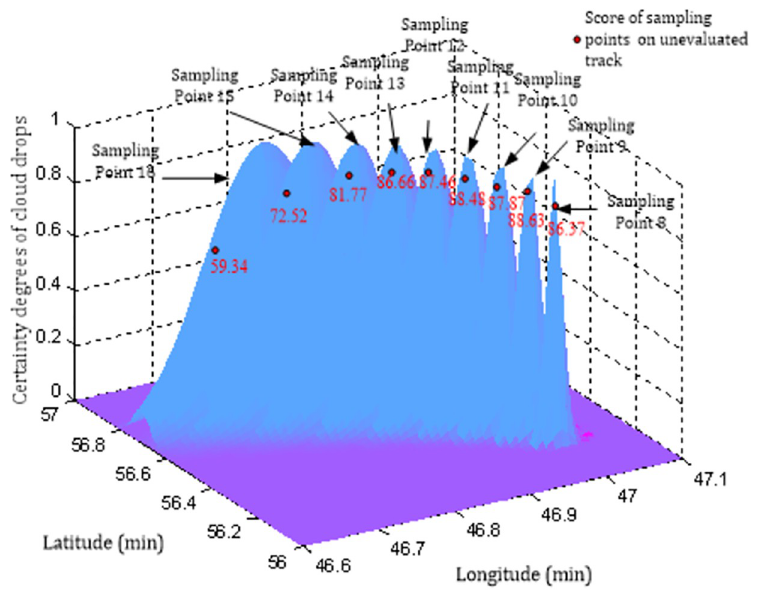
Fig 12. Modified expected surfaces of sampling point No.8–16.